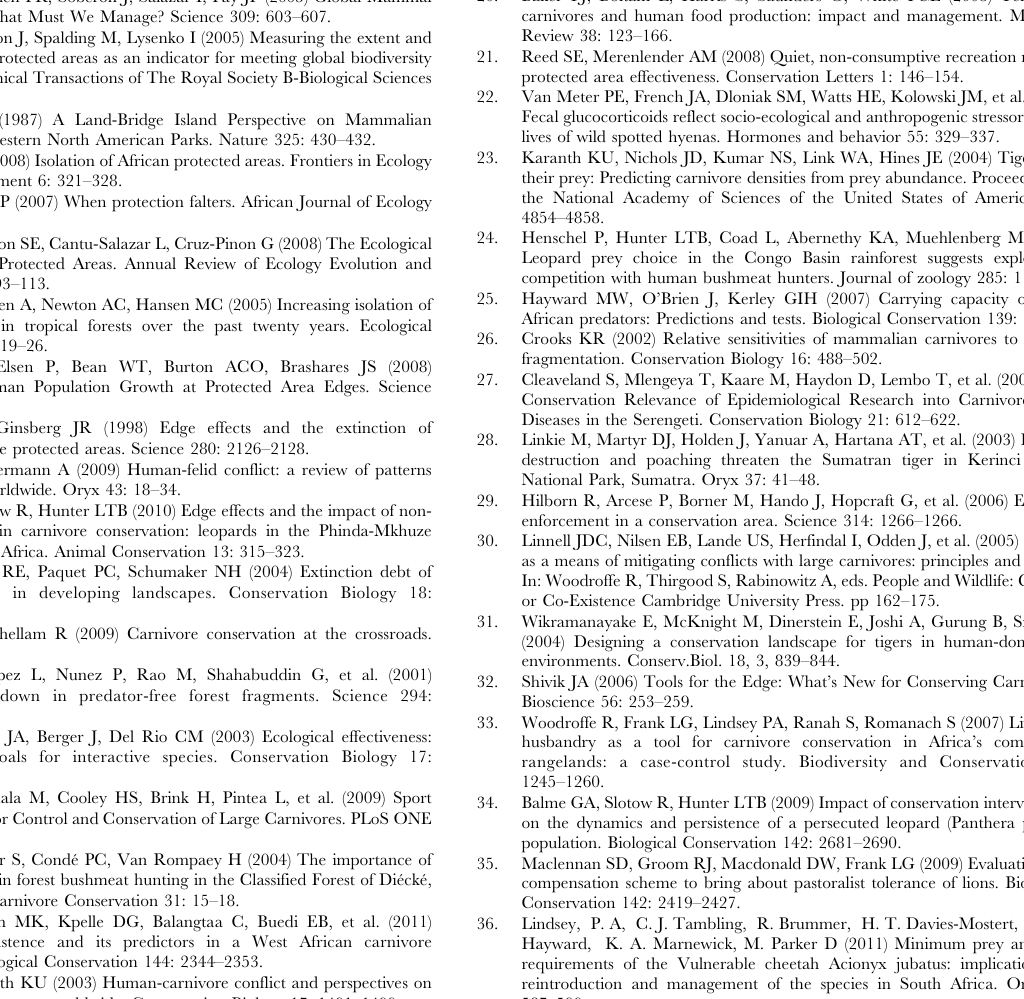
Table S1 Scientific names and mean body mass for all species included in the study, with relative abundance for prey species detected by patrol and camera-trap surveys in Mole National Park, Ghana